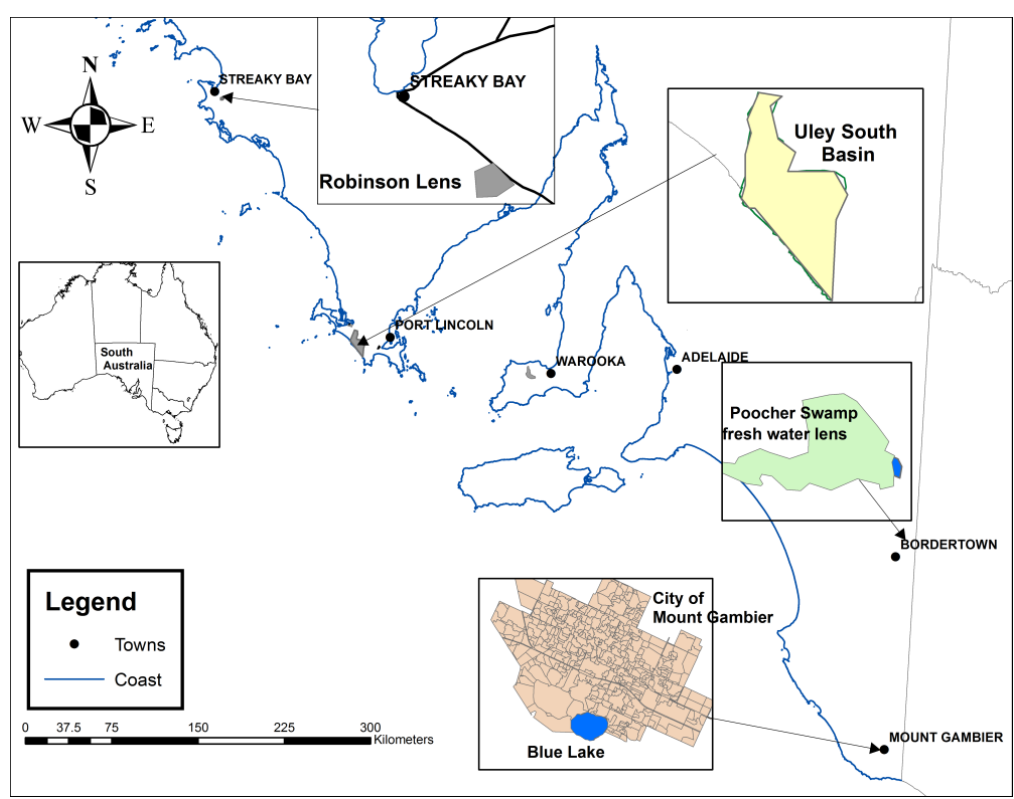
Figure 1. Location of study